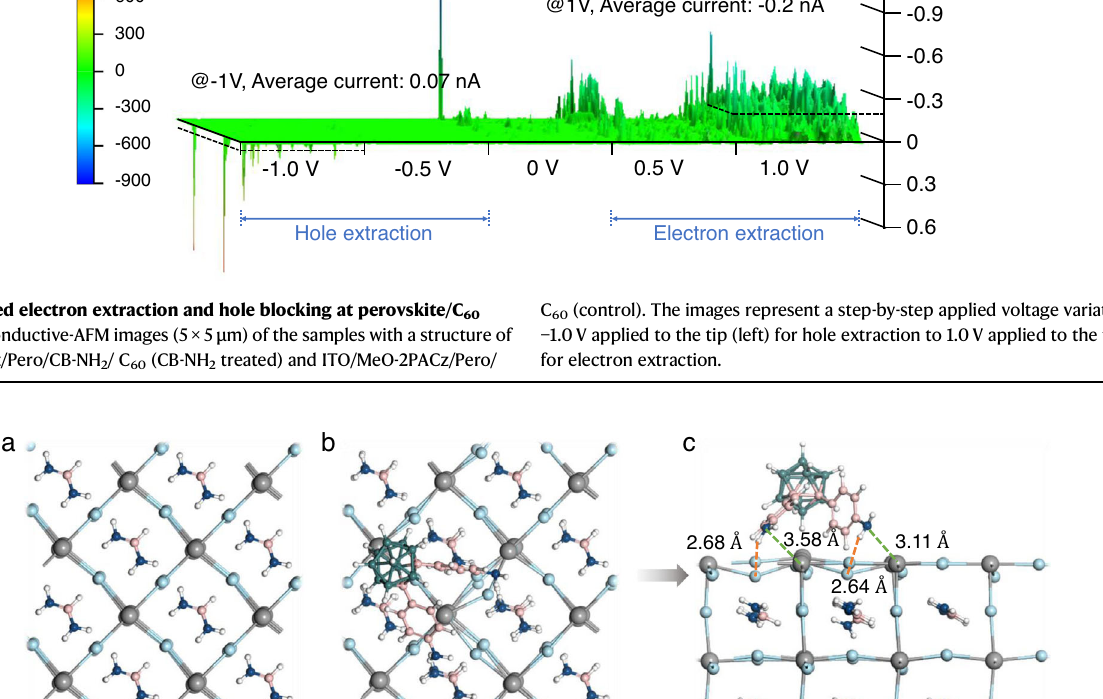
N-Pb are depicted. Color scheme: Pb: gray; I: light blue; C: pink; N: dark blue; B: green; H: white.